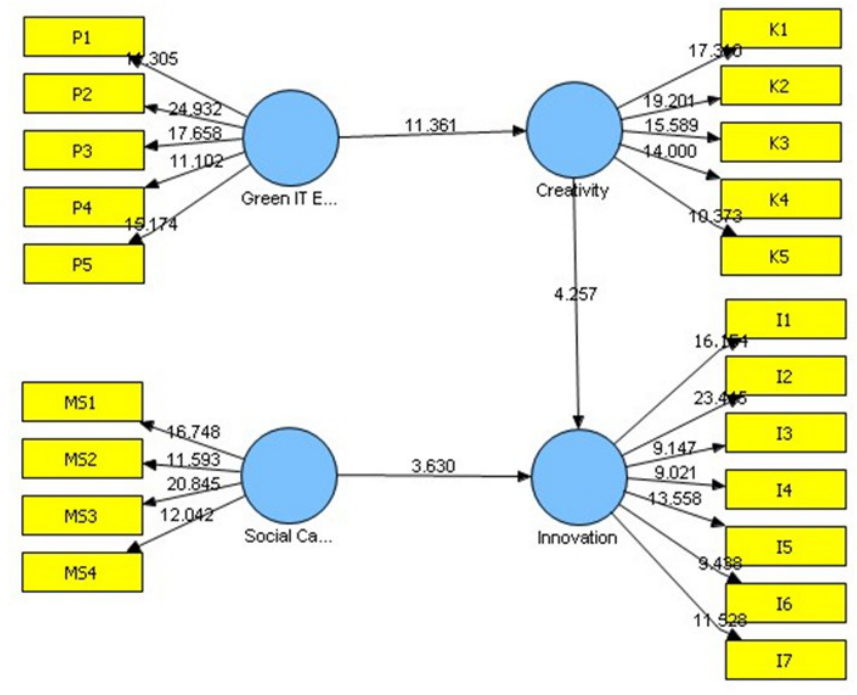
Figure. 1. Result of the Structural